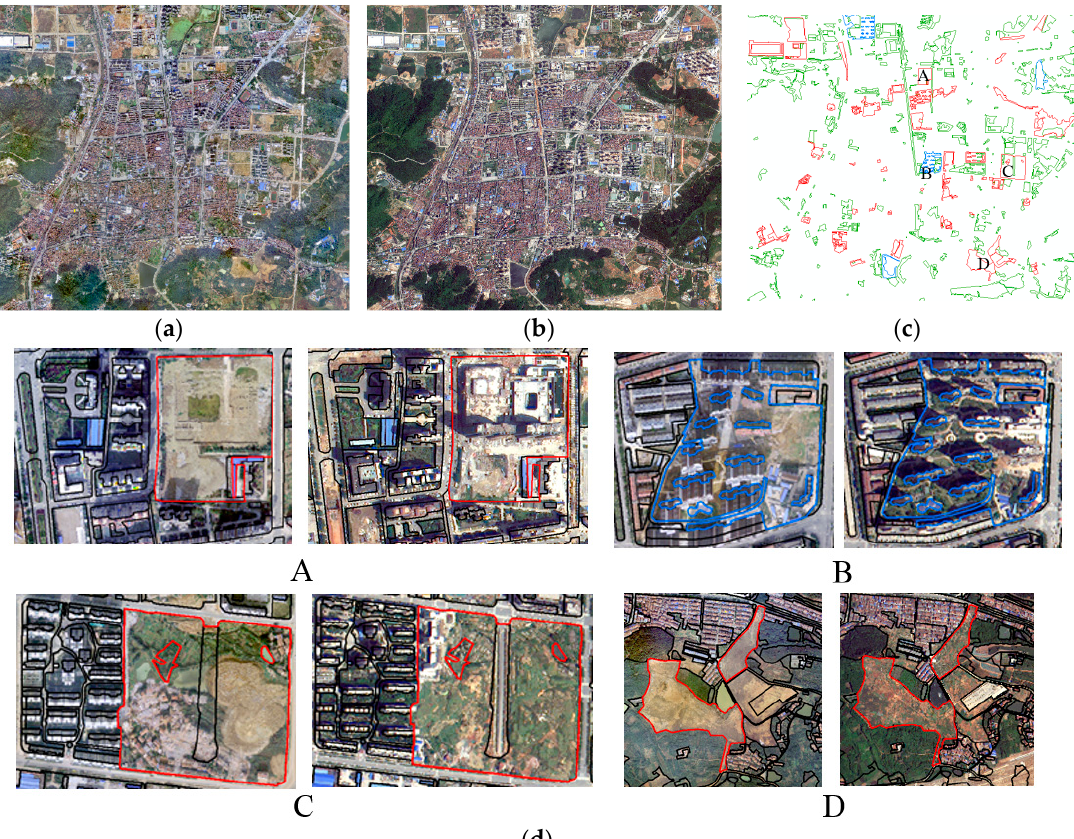
Figure 11. The zoomed-in area with 5535×4805 pixels. ( a ) image in 2014; ( b ) image in 2017; ( c ) the polygon-based change map, where the white background is the unchanged area, green polygons are correctly detected changed objects, red and blue are false positive and false negative; ( d ) four zoom-in area. A, C and D are unchanged construction sites that were wrongly classified into buildings, plants and constructions, plants and crops, respectively. B is a missing detected polygon where the right part of the construction site has been changed into buildings.